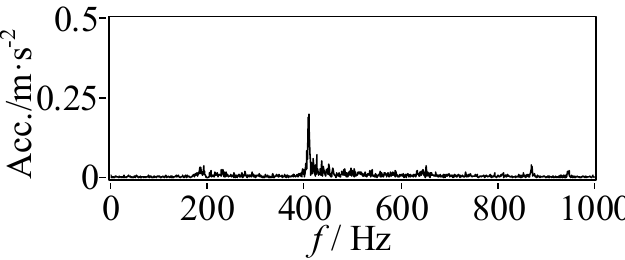
Figure 12. Base acceleration spectrum of the rotor in static suspension.